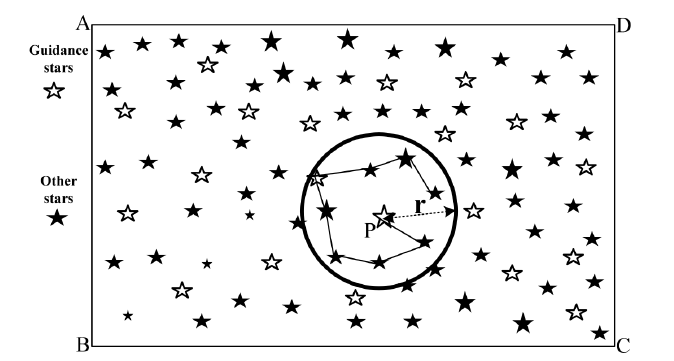
Figure 5. Feature extraction for one star set using AAC algorithm (reprinted from